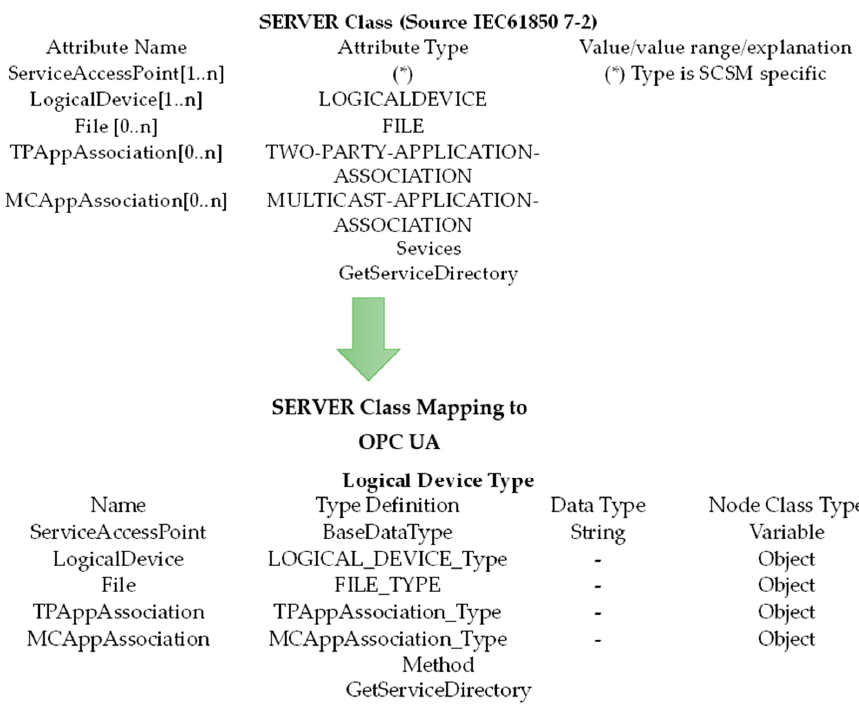
Figure 7. Abstract Communication Service Interface (ACSI) server class mapping.